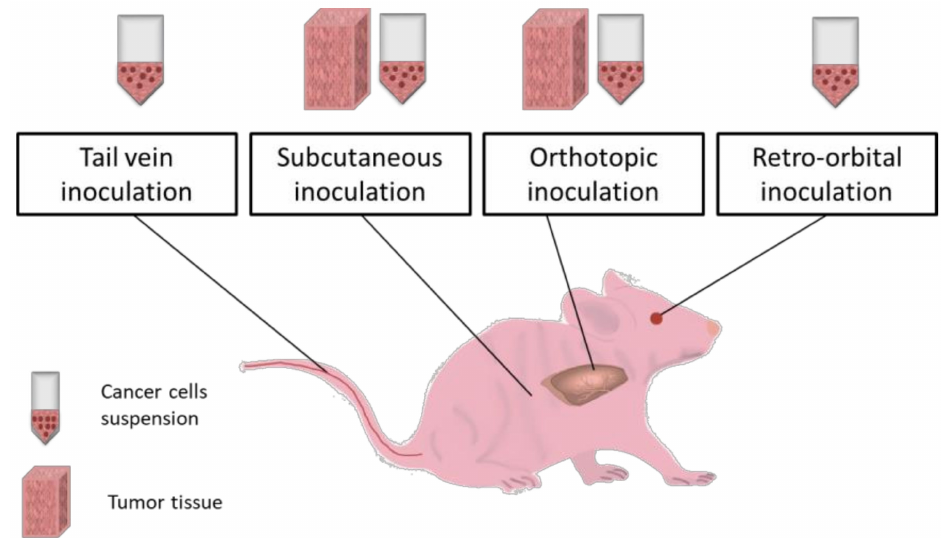
Figure 2. In vivo routes of cancer inoculation. Tail vein, retro-orbital, subcutaneous and orthotopic routes are suitable for cancer inoculation in laboratory mice via cancer cells suspension injection. Some of these paths (tail vein and retro-orbital) ensure minimal invasiveness and safety for the animal, providing promising results especially for cancer hematological malignancies. Moreover, tail vein mode can be engaged for treatments administration and body fluids sampling [104] while retro-orbital route is more stressful for the animal [105]. Subcutaneous implantation technique is generally used in cancer research studies because of its easiness in execution and fast results monitorization but is not prone to gain metastatic features [106]. On the other hand, orthotopic route has the capacity to mimic live organism conditions during tumor progression and can lead to metastases [107,108]. Both two routes (subcutaneous and orthotopic) are applicable for both cell suspension and tumor tissue implantation using microsurgery. Tissue samples are characterized by heterogenous cellular populations and integrity of organization level. In addition, the adequate sites for tissue implantation have large area and layered structures, and this can favor the metastatic profile allowing cells networks development and movement [109]. Subcutaneous and orthotopic routes can be explored for implantation of di ff erent electronic devices or materials which can serve as therapeutic platforms including molecular levels evaluators